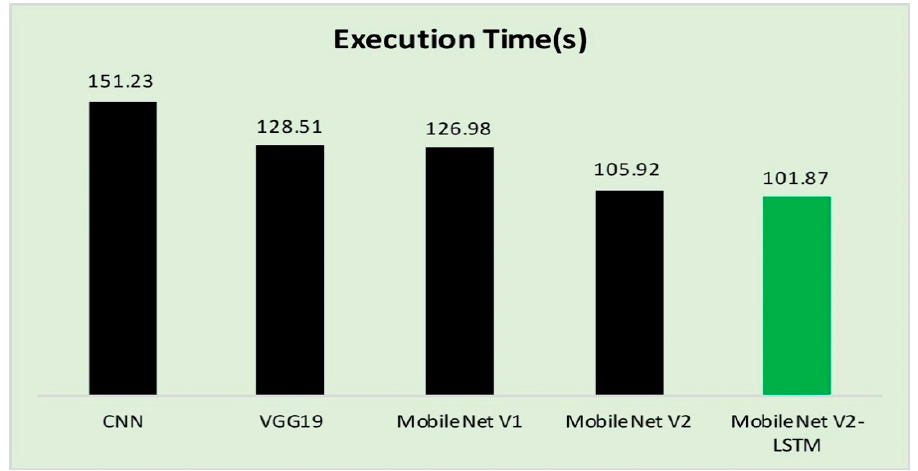
Figure 13. The execution time of MobileNet V2 with LSTM and other approaches.